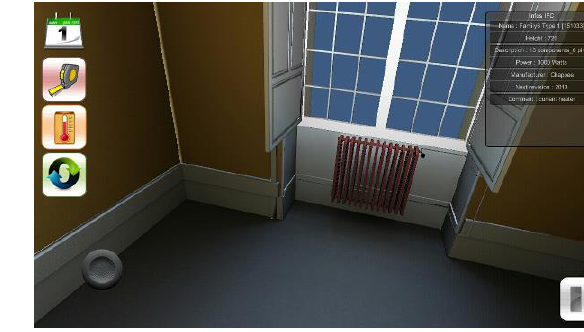
Figure 7. Visualization of simulated data